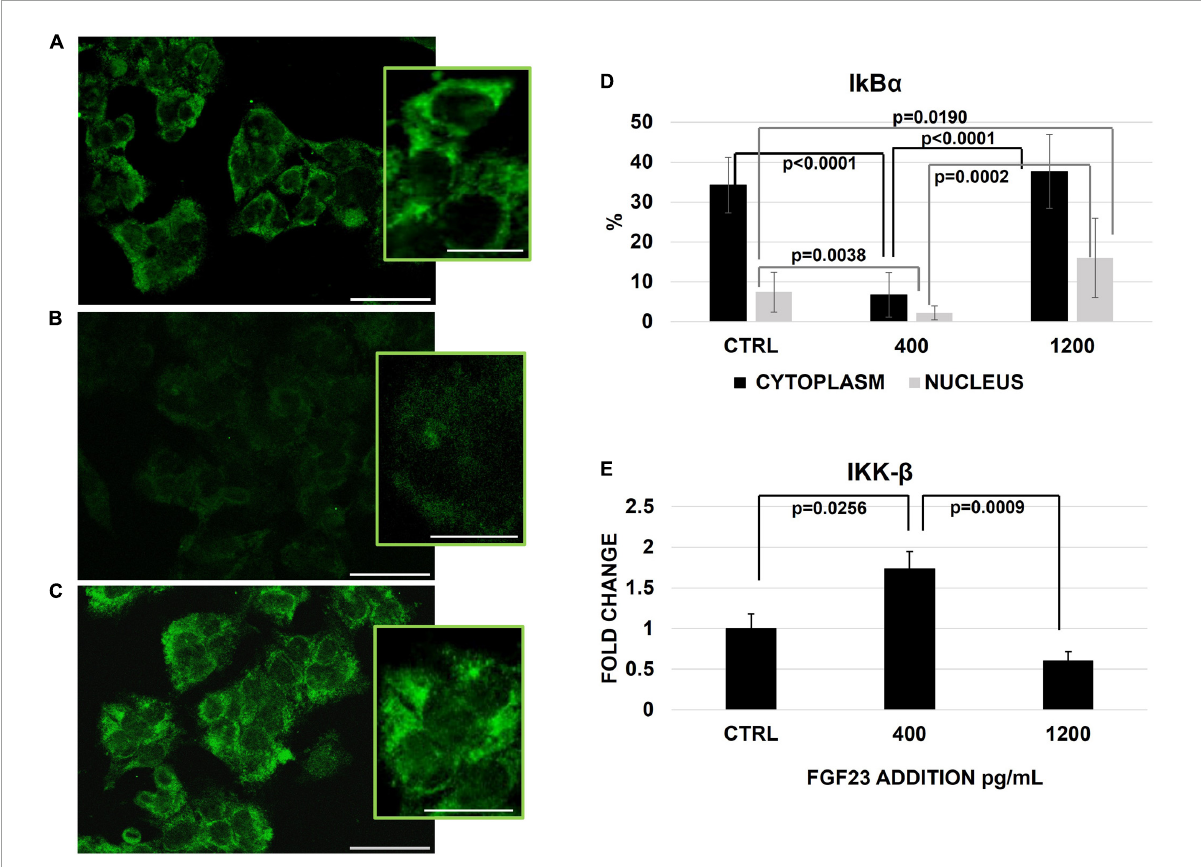
FIGURE3 Immunostaining of I κ B α in the ctrl (A) and 24 h after the addition of 400 (B) and 1,200 (C) pg/ml of FGF23 visualized by FITC and its staining quantification with ImageJ program in the nucleus and cytoplasm. Changes of IKK- β mRNA expression 24 h after the addition of FGF23 at 400 pg/ml and at 1,200 pg/ml. N = 11 (D) , N = 6 (E) . Scale bar 50 µ